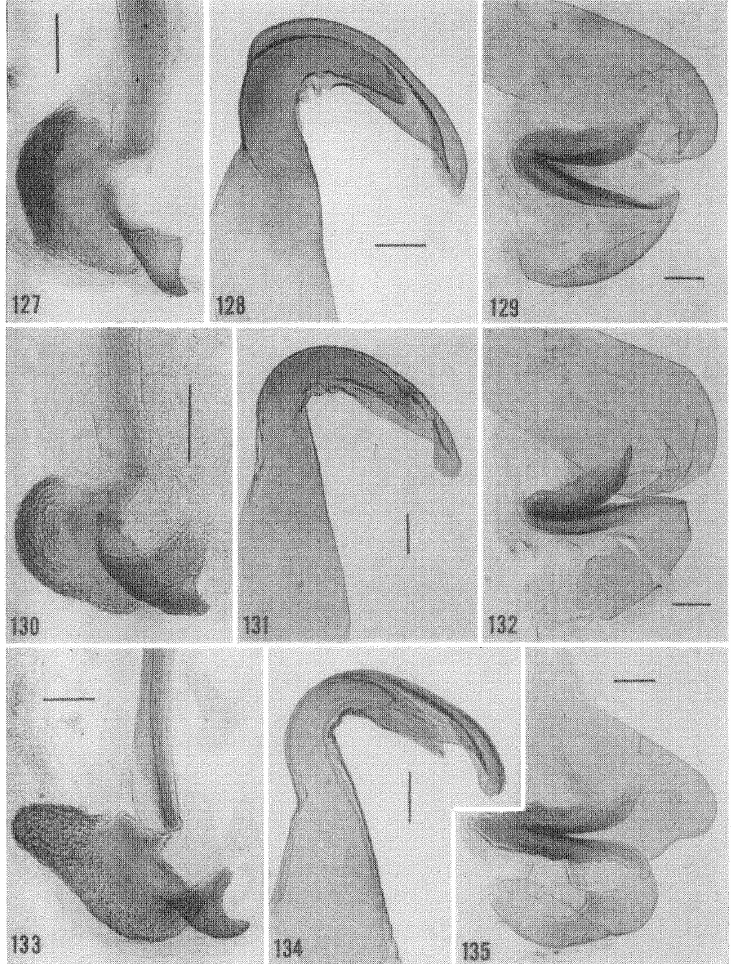
Figures 127-135. Male genital phallomeres of Cyrtotria spp. 127-129. (998 L). C. orientalis (from shown in Fig. 102). 130-132. (996 L). C. calucina (]rom $ shown in Fig. 104). 13-135. (55 BMNH). C. ;odu- riformis. Natal, South Africa (de,t. Prineis). (scale-- 0.1